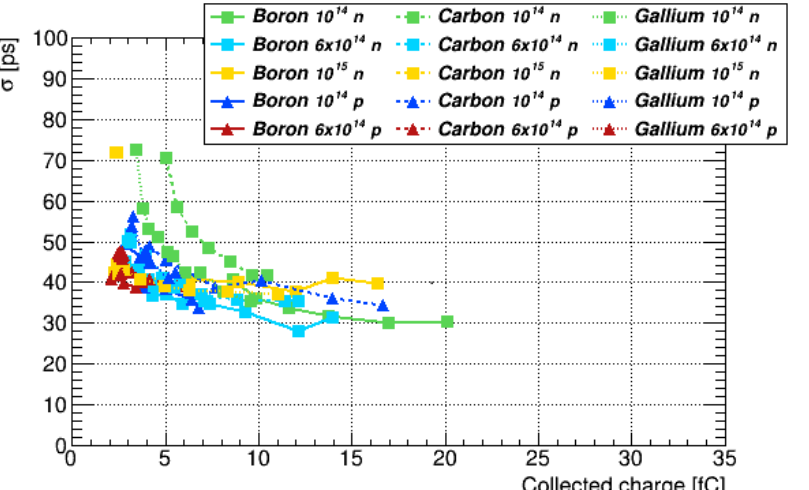
Figure A2. Time resolution as a function of the collected charge for CNM LGADs irradiated up to a fluence of 10 15 n eq /cm 2 at − 30°C.